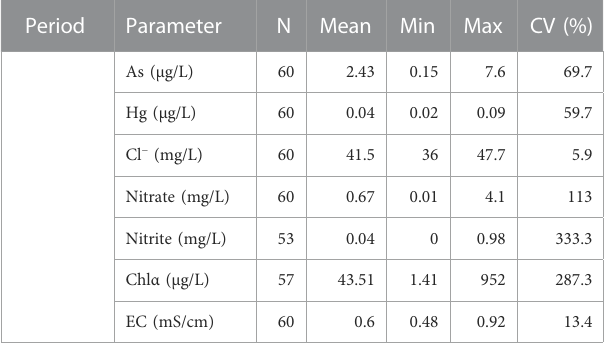
TABLE 2 Temporal changes of the physicochemical parameters in the study